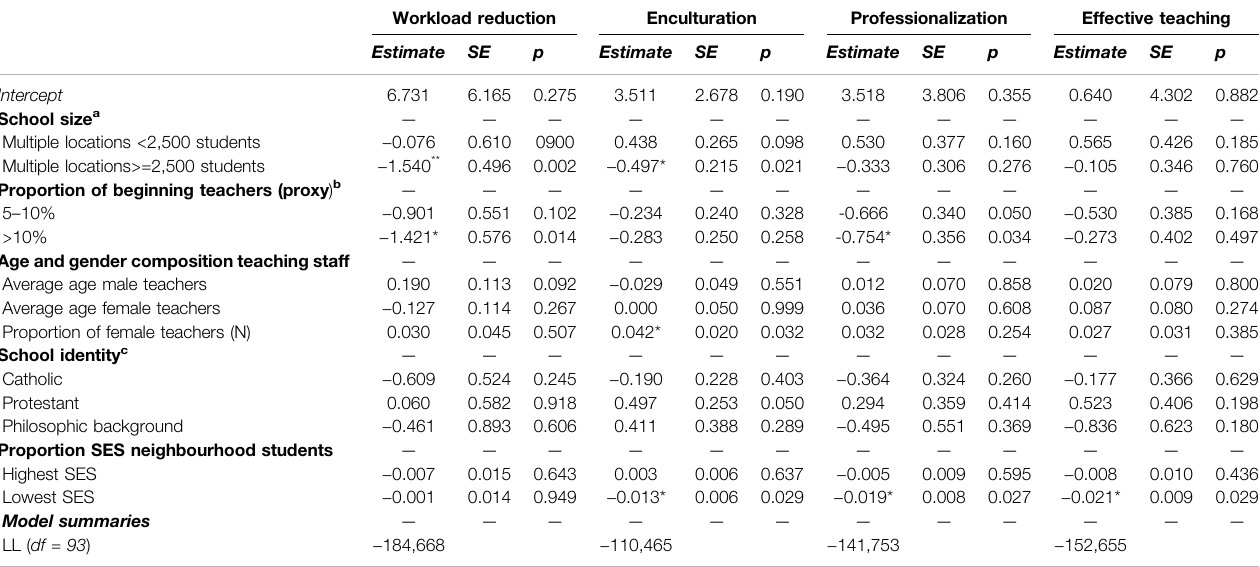
TABLE 4 | Linear regression models: reported support activities by BTs and school characteristics, four induction elements, PDSs (N (cid:1) 89).